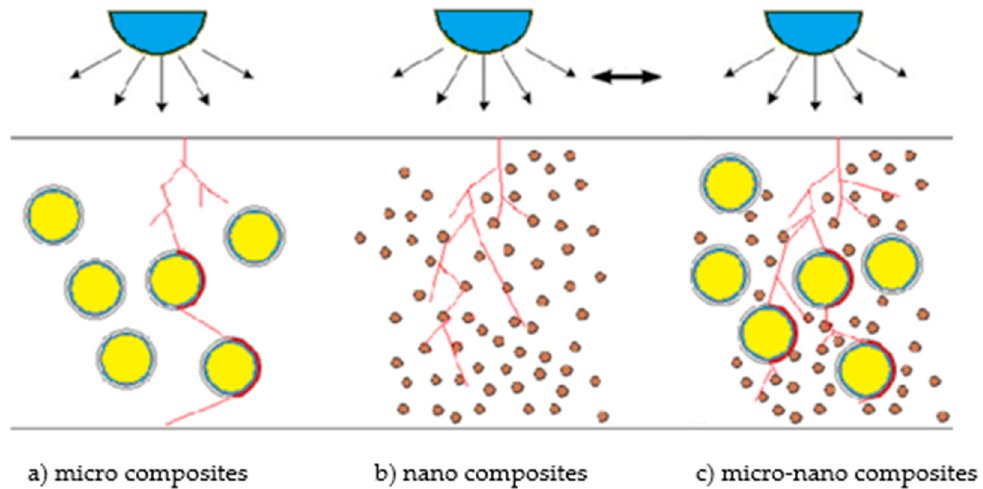
Figure 13. Electronics energy transport patterns of di ff erent